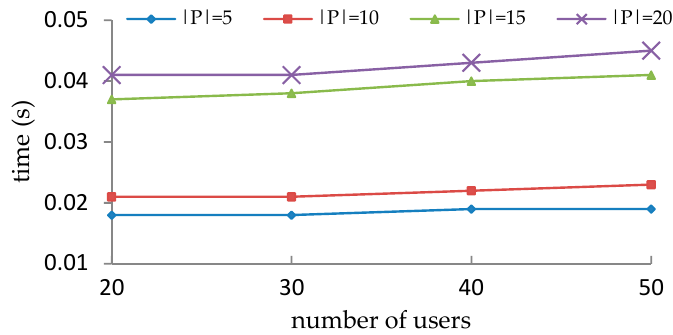
Figure 8. Execution time for different numbers of users and rules.